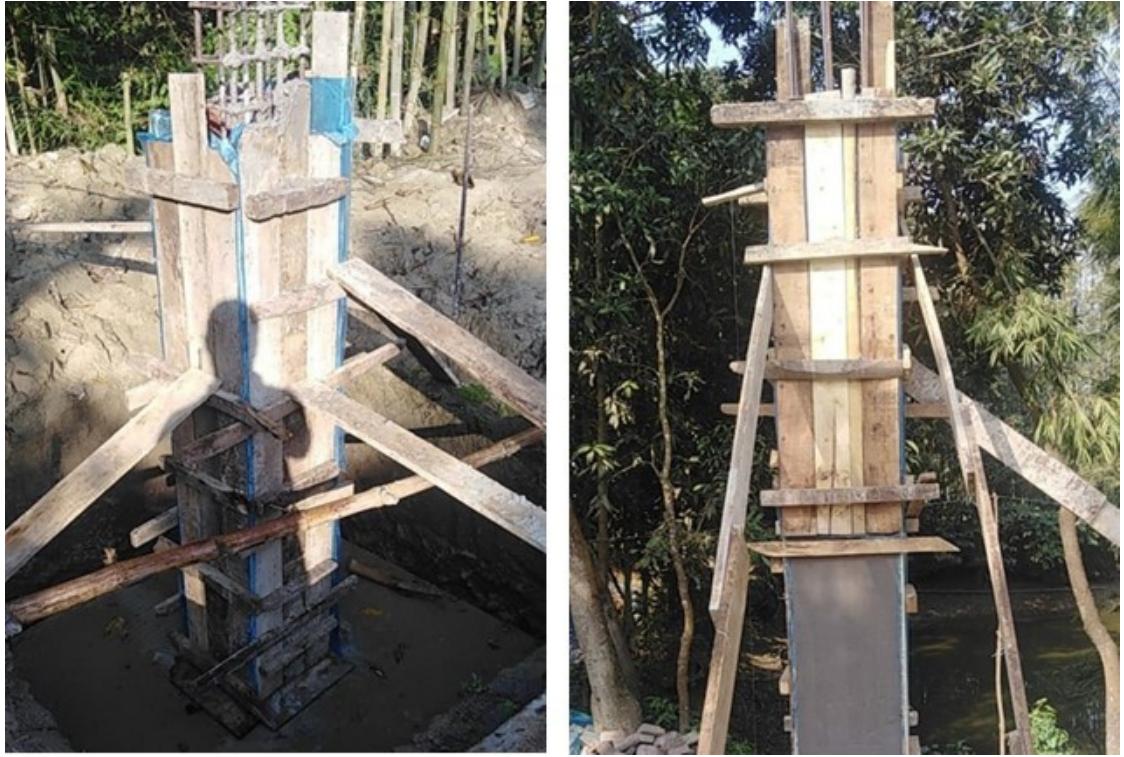
Figure 1. Shoring of formwork for concrete grade beams (used with permission from Khadem [23]).